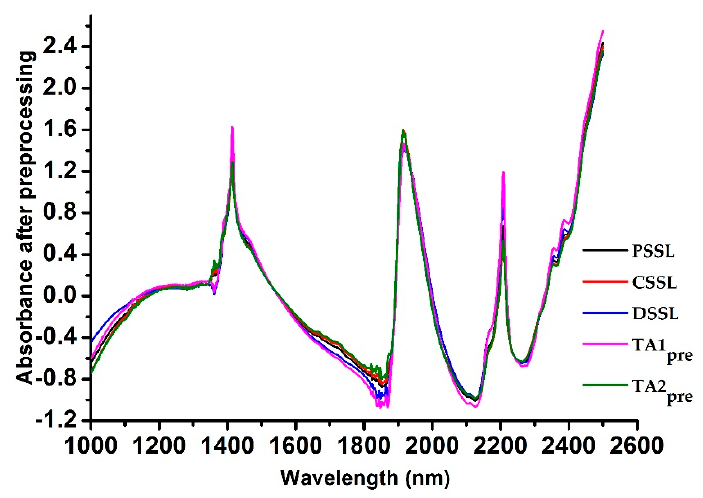
Figure 3. Average NIR spectra of soil sample sets after preprocessing.